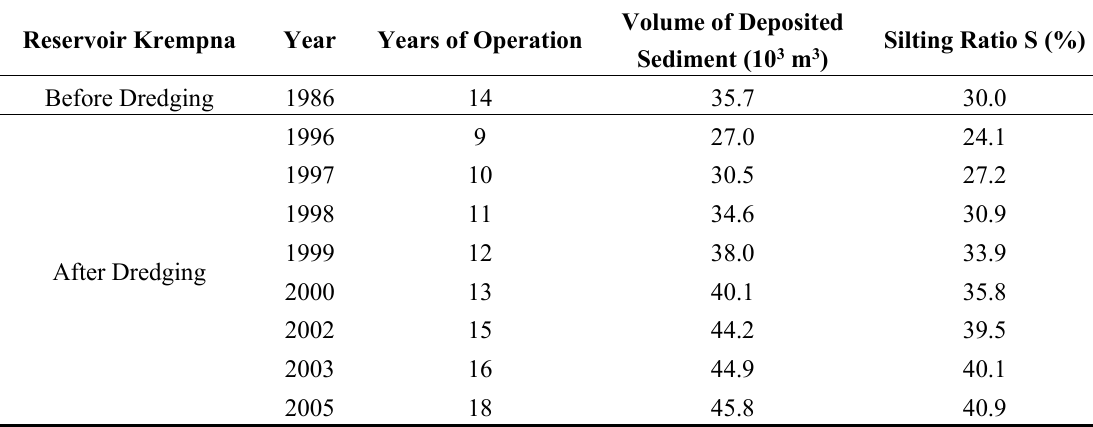
Table 4. Volume of deposited sediment and the silting rate of Krempna reservoir.